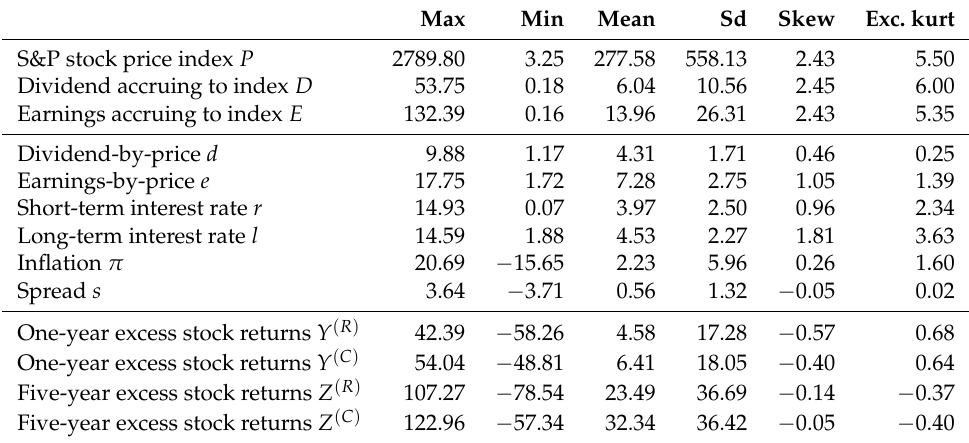
Table 1. US market data